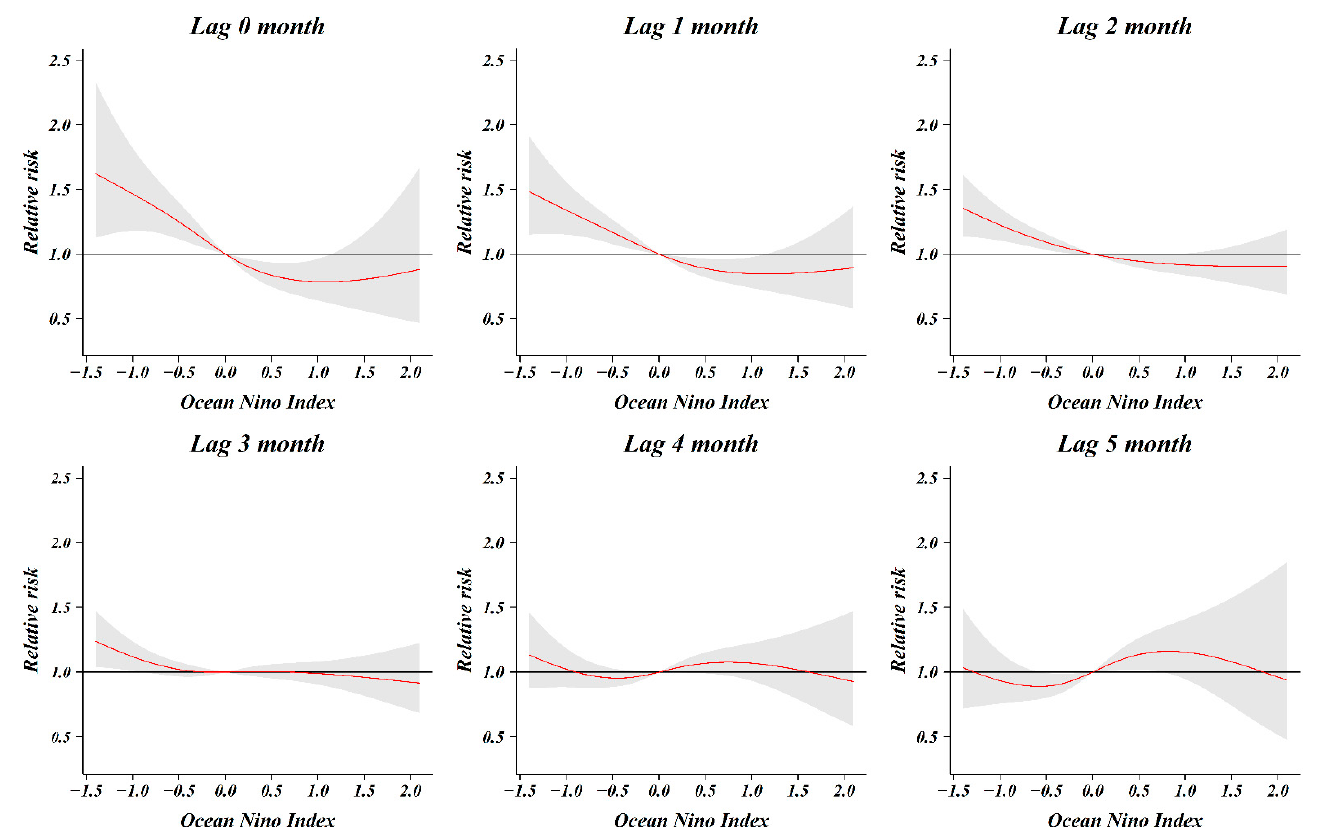
Figure 4. Relative risk according to the lag month of Oceanic Niño Index (ONI).